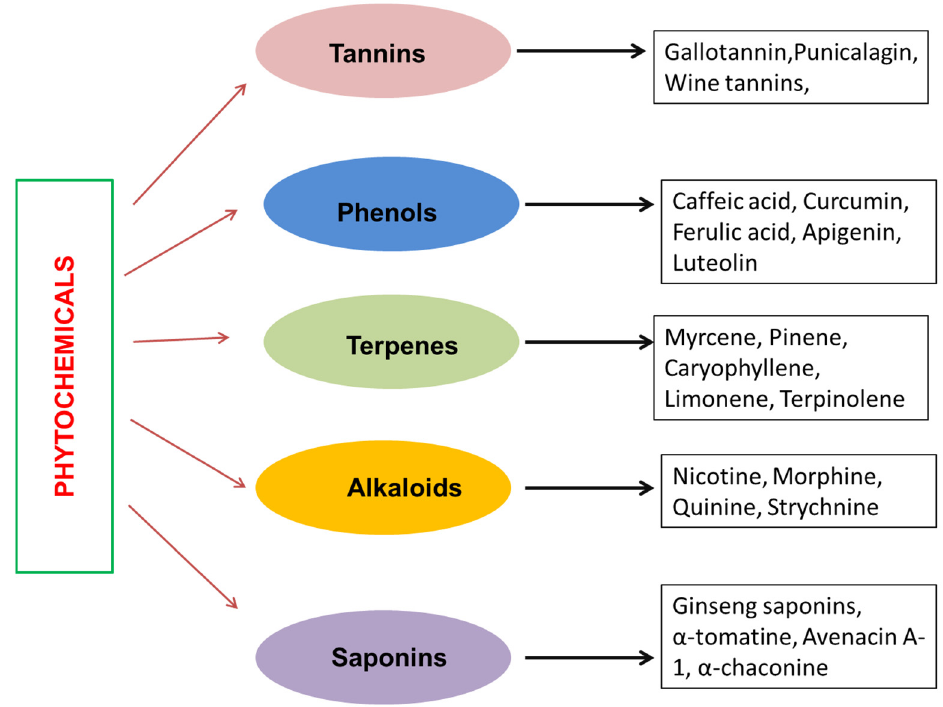
Figure 3. The diverse phytochemicals originating from plant sources are distinguished into five major classes based on their chemical structure and properties. The figure illustrates the different classes and gives examples of each type. Table 1. Some of the phytochemicals used against cancer, the methodology, and the fi nal outcomes.